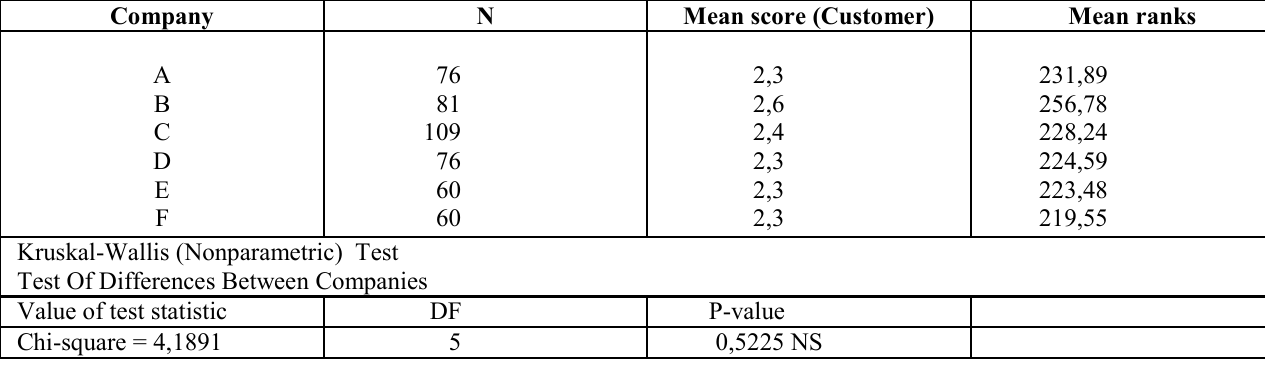
Table 4 : Variable: Customer Oriented Vs Accounting Oriented Company Means Company